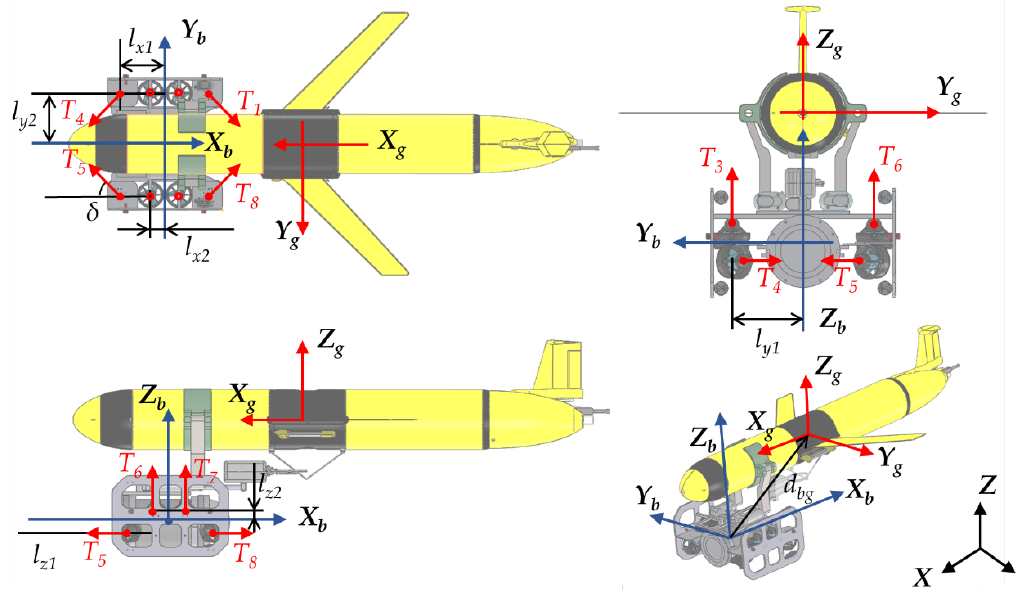
Figure 4. Schematic drawing of the glider recovery system using the ROV.